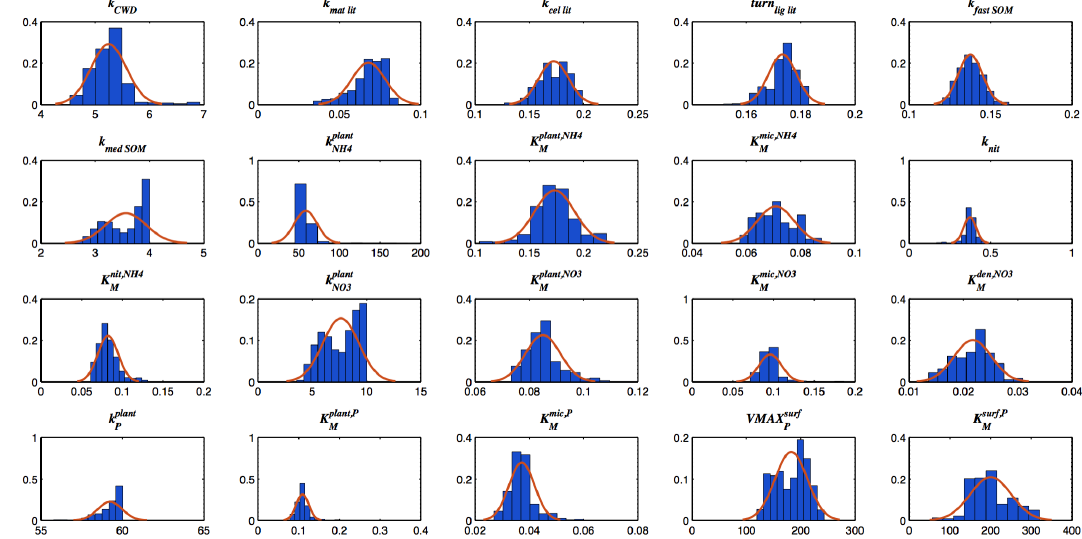
Figure A3. Posterior model parameters (blue bars) fitted to Gaussian distribution (red